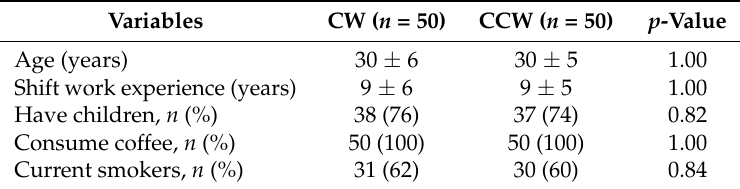
Table 1. Demographics of the study population.